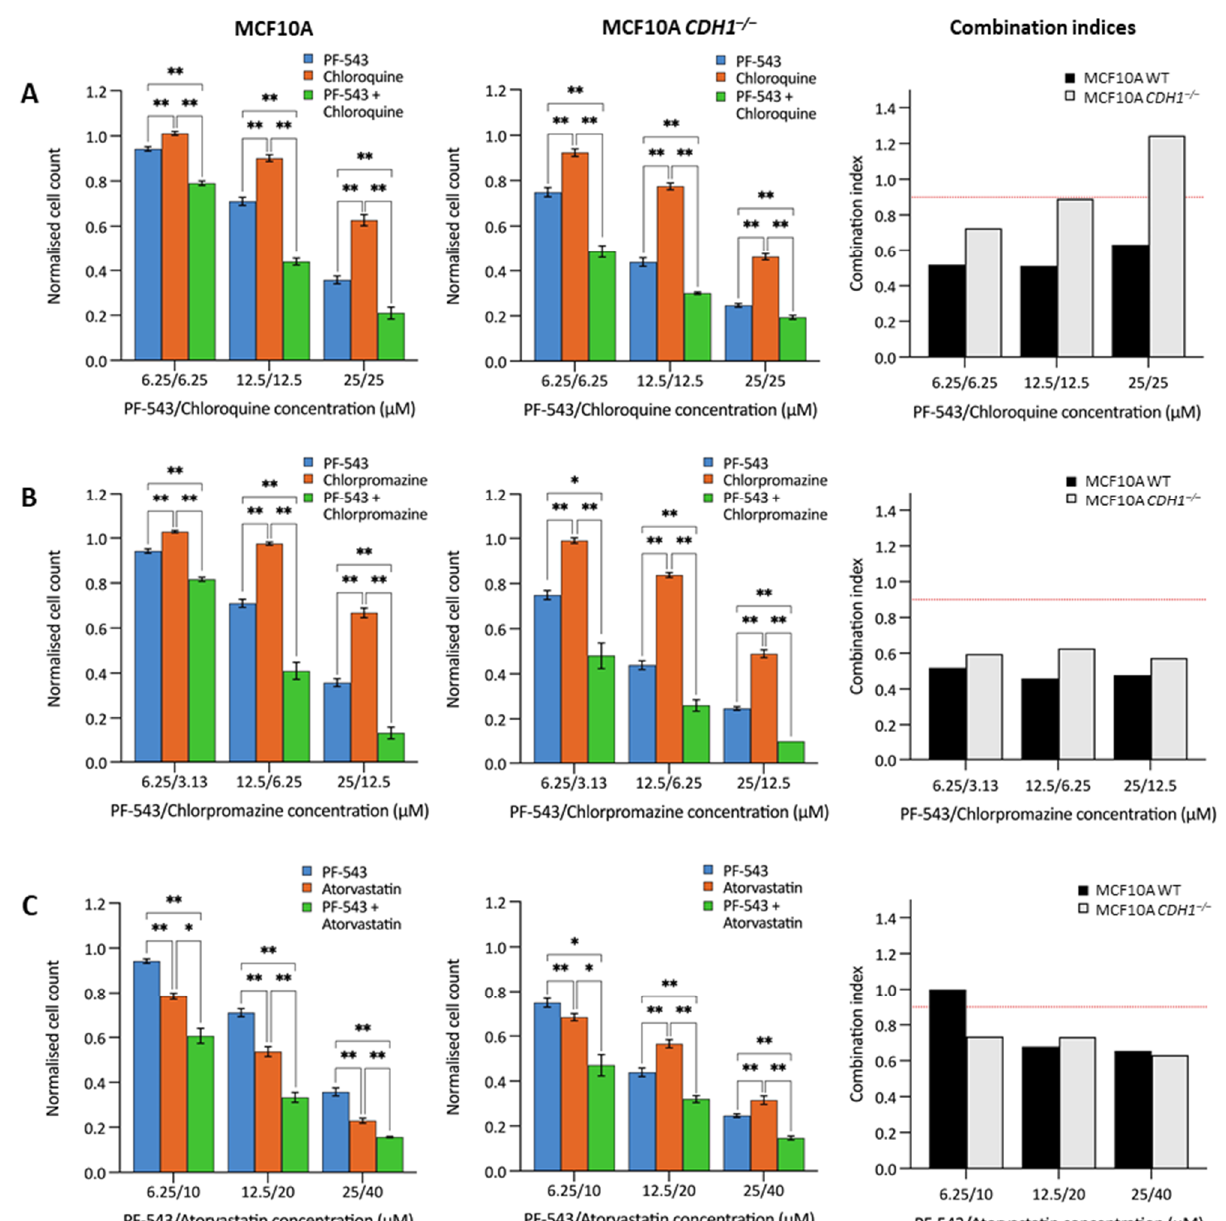
Figure 5. Efficacy of candidate compound combinations. MCF10A (left) and MCF10A CDH1 –/– (middle) cells were drugged with P5-543 in combination with ( A ) chloroquine, ( B ) chlorpromazine, or ( C ) atorvastatin, then viability was quantified through nuclei counting, and normalization to vehicle controls. Treatment with single inhibitors is also depicted. Although an 8-point serial dilution was assessed, only the three greatest concentrations are shown. Combination index values (CI, right) indicate drug interactions. Synergistic effects are represented by CI > 0.9 (depicted by dotted red line), additive effects by CI values between 0.9 and 1.1, and antagonistic effects by CI < 1.1. Error bars depict +/− 1 standard error of the mean. P -values were calculated using Student’s t -test; * p < 0.05, ** p < 0.01.